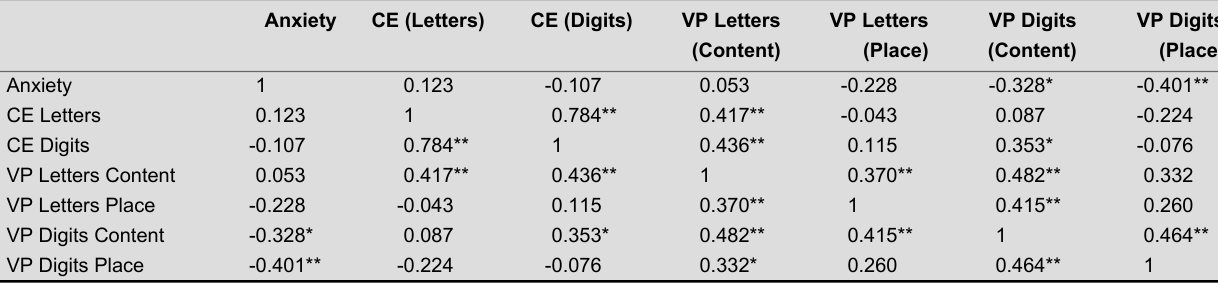
Correlations between mathematical anxiety and all working memory